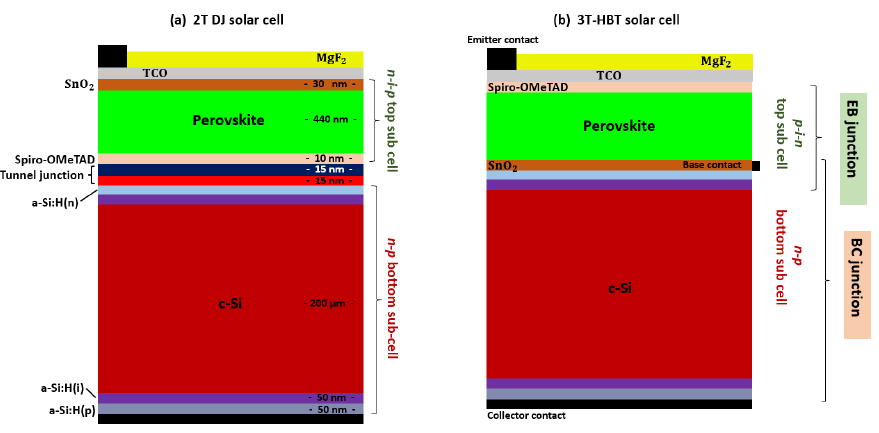
Figure 3. Schematic view of the simulated PVK/HIT-silicon tandems with ( a ) 2T DJ structure and ( b ) 3T-HBT